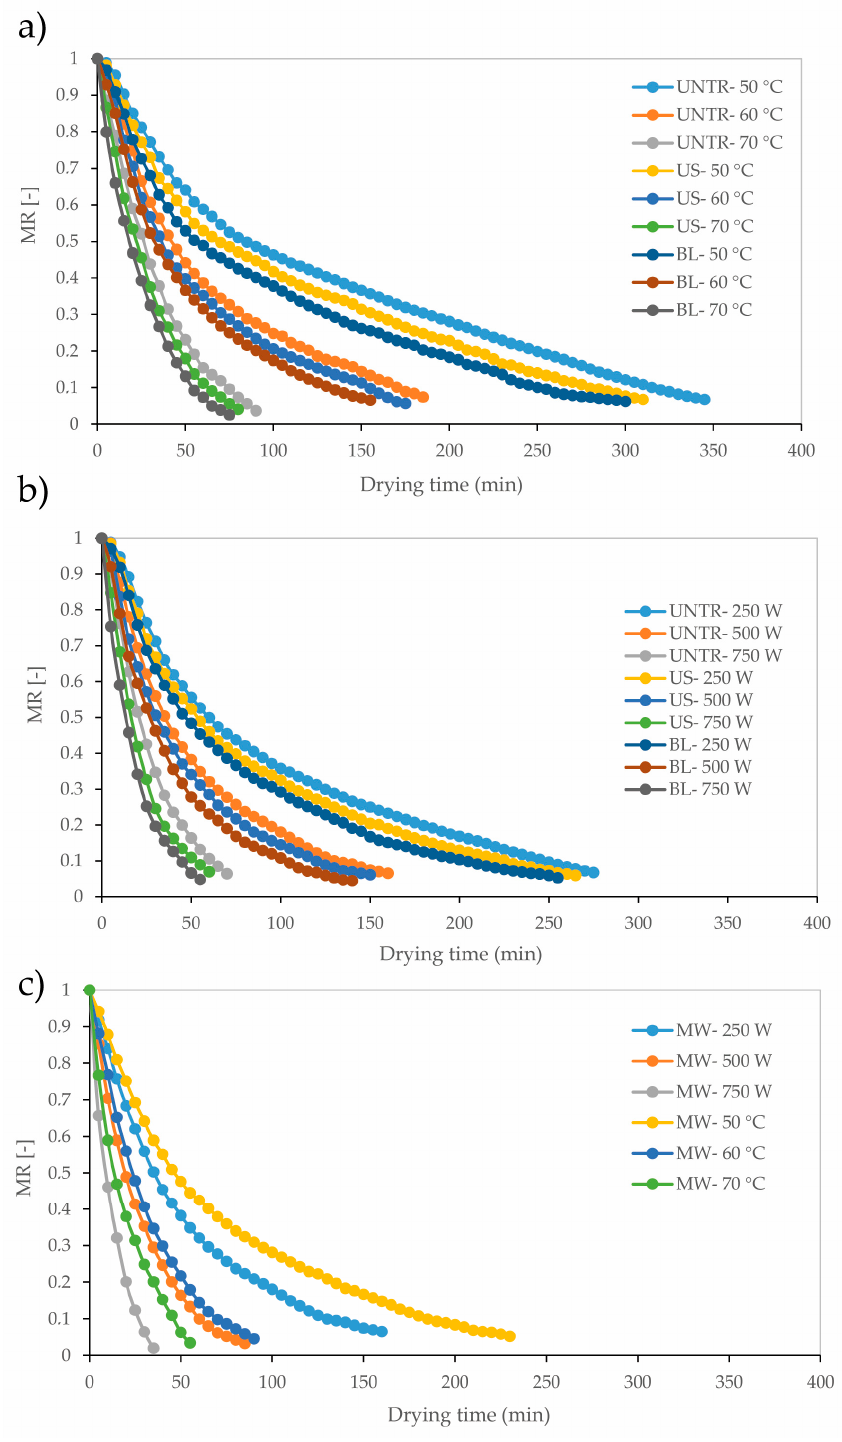
Figure 1. Changes in the moisture ratio of terebinth drying using ultrasound and blanching pretreat- ments in ( a ) convective dryer; ( b ) infrared dryer; ( c ) using microwave pretreatment in convective and infrared